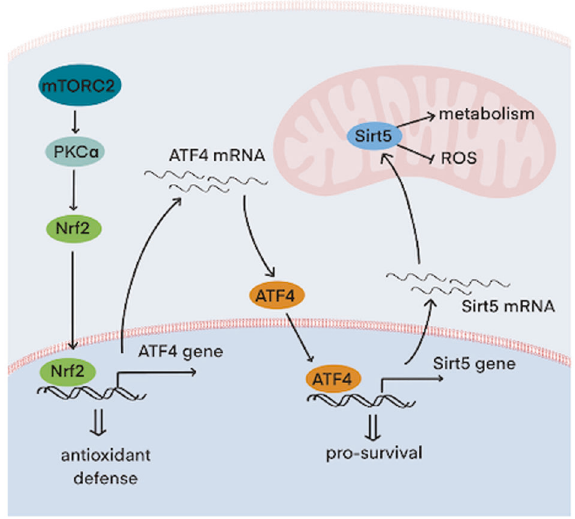
Fig. 8 Model for a stressed-induced mTORC2 signaling pathway targeting ATF4/Sirt5 in cell survival. mTORC2 senses cellular stresses arising from glutamine deprivation or an acute inhibitionof glutamine metabolism. Upon its phosphorylation by mTORC2, PKC targets Nrf2 which triggers sustained ATF4 and Sirt5 transcription and subsequent protein production to promote cell survival in the face of metabolic and oxidative